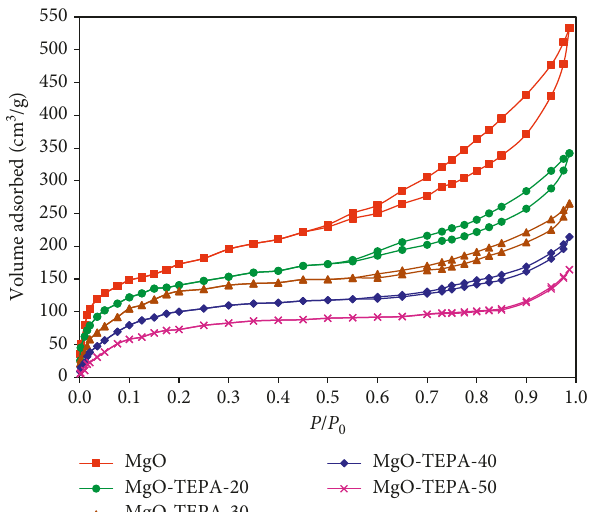
Figure 3: Adsorption-desorption isotherms of MgO with different TEPA loadings.